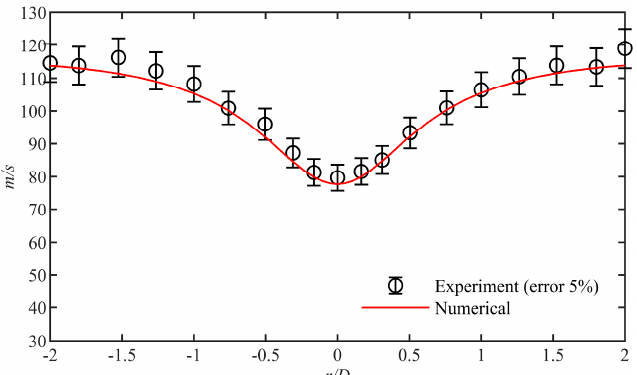
Figure 4. Comparison of experimental (with 5% error) and numerical simulation results for the radial velocity distribution at 0.5 D from stagnation point on a no-screen thermocouple (NST).